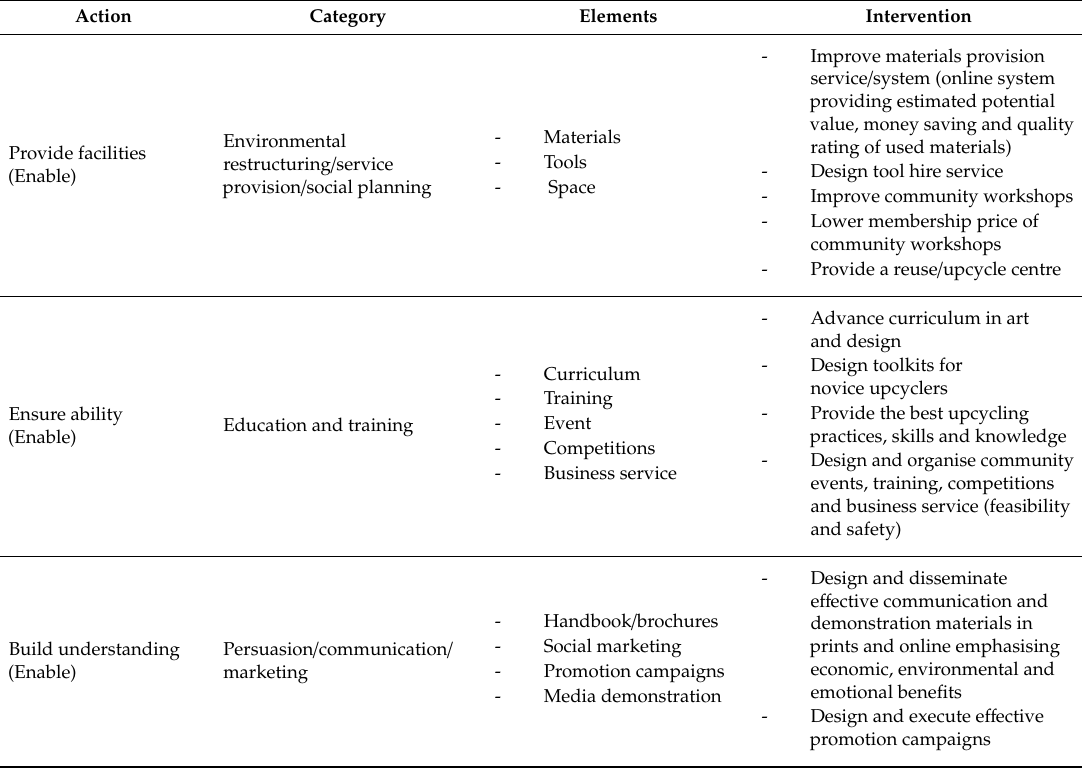
Table 3. Interventions for scaling